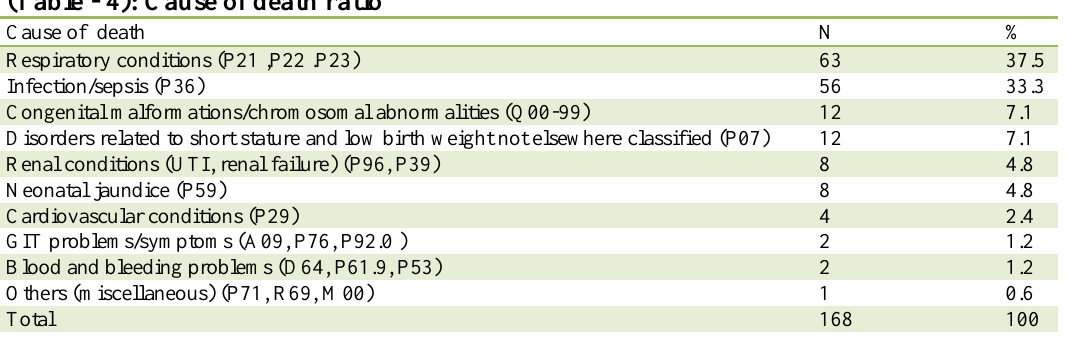
(Table - 4): Cause of death